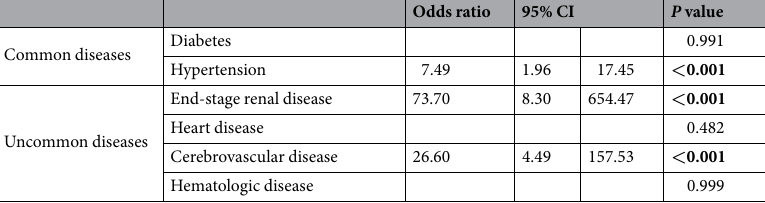
Table 4. Multiple logistic analysis of systemic factors associated with multiple retinal nerve fiber layer defect. * Statistically significant differences ( P < 0.05) assessed by logistic regression analysis are indicated in